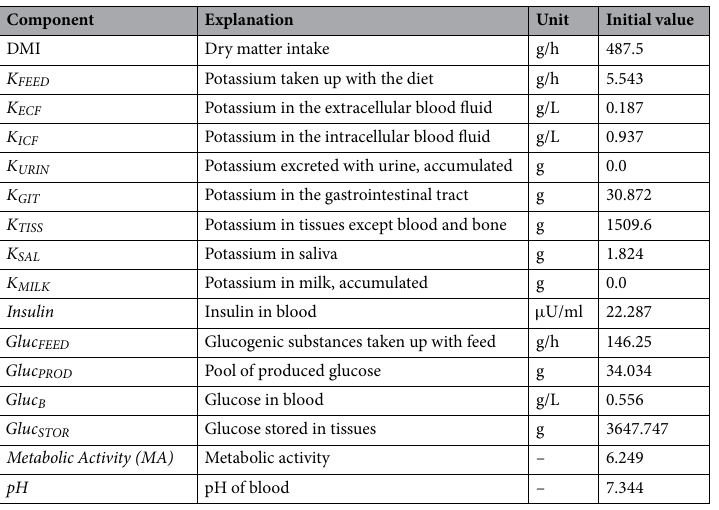
Table 1. Components and units in the model for potassium balance in dairy cows. Note that the components K ECF and K ICF are calculated in g/L, whereas simulation results within this paper are shown in mmol/L.